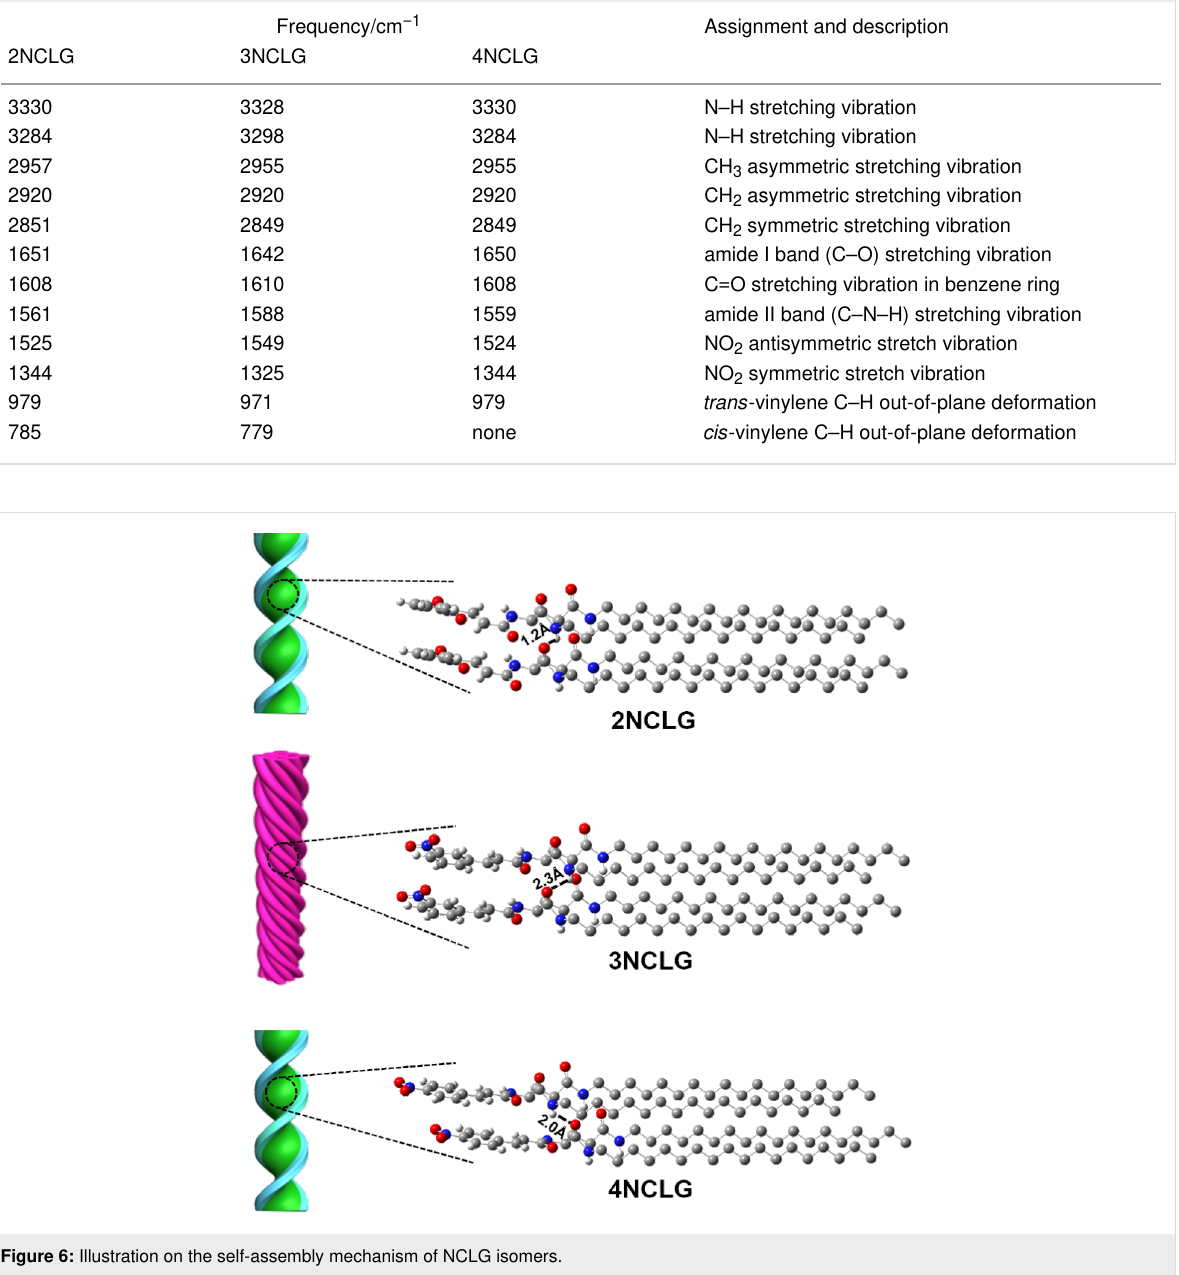
formation of right-handed nanohelical structures, while the opposite chirality of the left-handed superhelix of 3NCLG was attributed to the weak hydrogen bonding in these